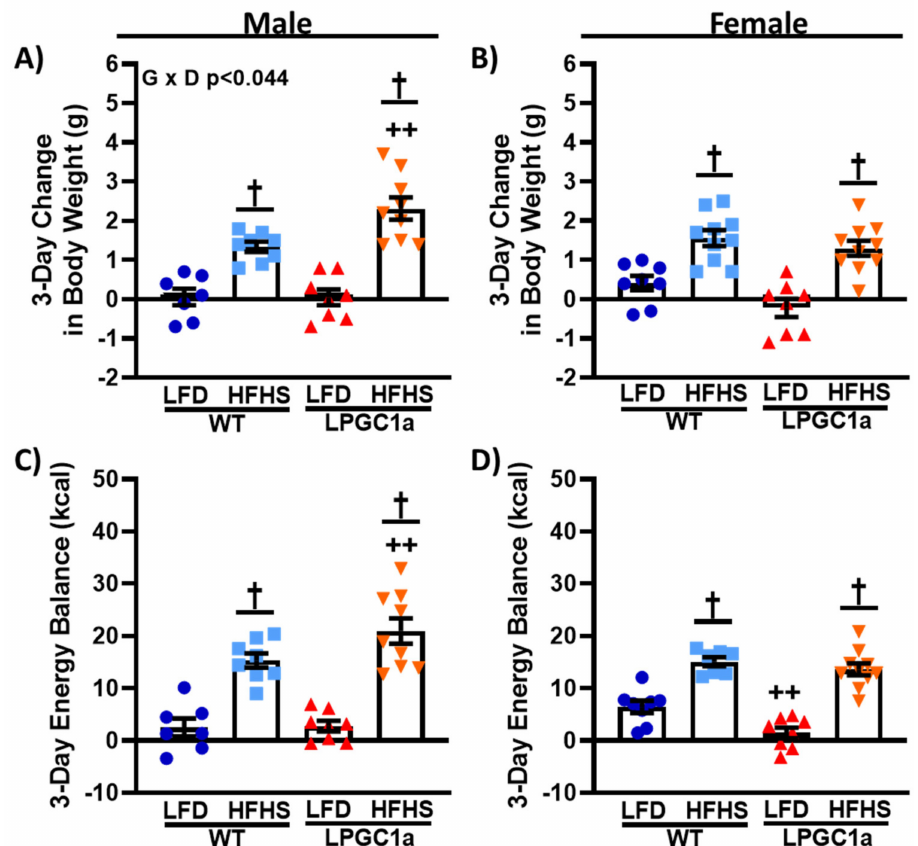
Figure 2. Male LPGC1a mice have greater short-term HFHS-induced weight gain. Body weight gain was assessed during the 3 days of the LFD or the HFHS diet in male ( A ) and female ( B ) WT and LPGC1a mice. Energy balance during the 3 day feeding intervention was determined as energy intake minus total EE for male ( C ) and female ( D ) mice. Individual data points and the group means ± SEM are displayed ( n = 7–10). Genotype Diet p < 0.05 interaction of genotype and diet, † p < 0.05 main effect of diet, ++ p < 0.05 WT vs. LPGC1a within